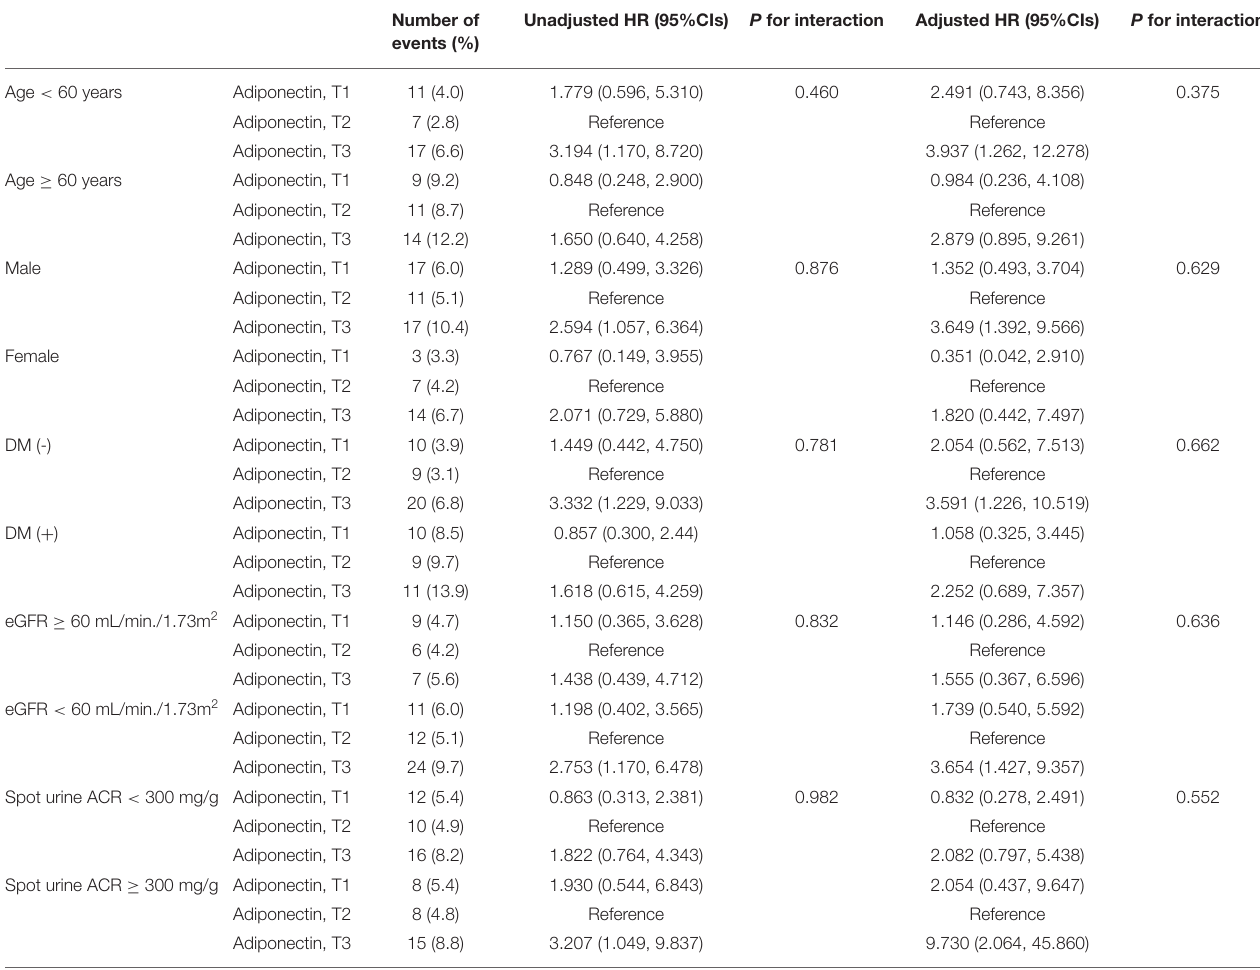
TABLE 4 | Cox regression analysis of serum adiponectin levels for fatal and non-fatal CV events in various subgroups. Number of Unadjusted HR (95%CIs) P for interaction Adjusted HR (95%CIs) P for events (%)